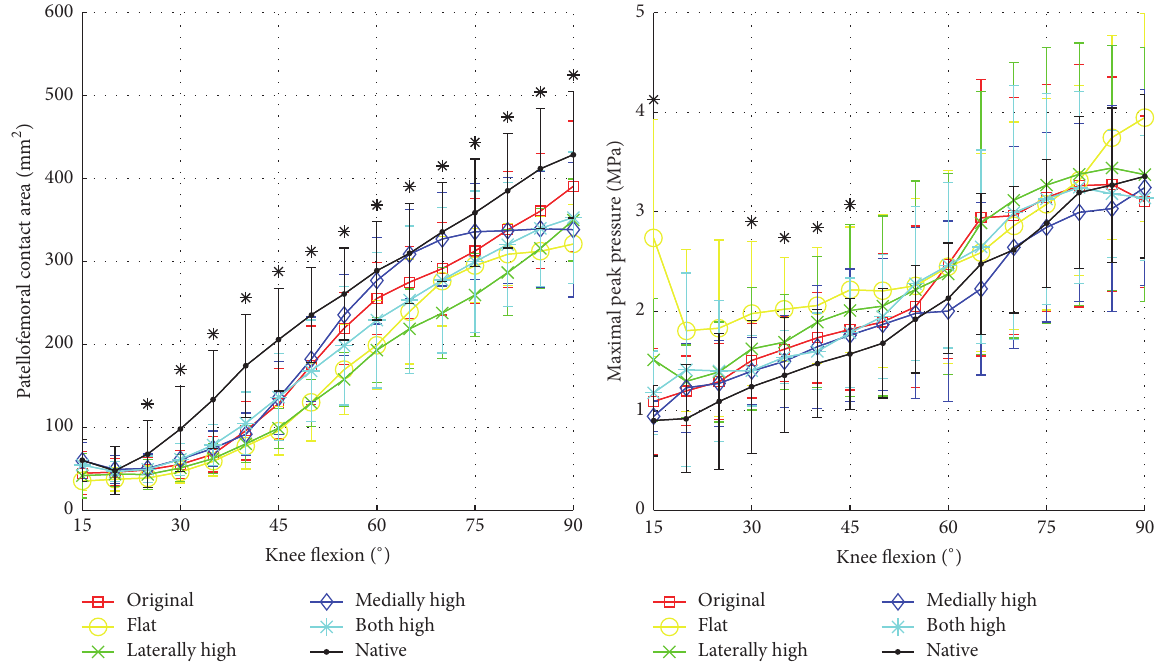
Figure 6: Patellofemoral contact area and maximum pressures with central muscle load after implantation of the different design variations without patellar resurfacing (native, original, flat, laterally high, medially high, and both high) ( ∗ significant difference in ANOVA).